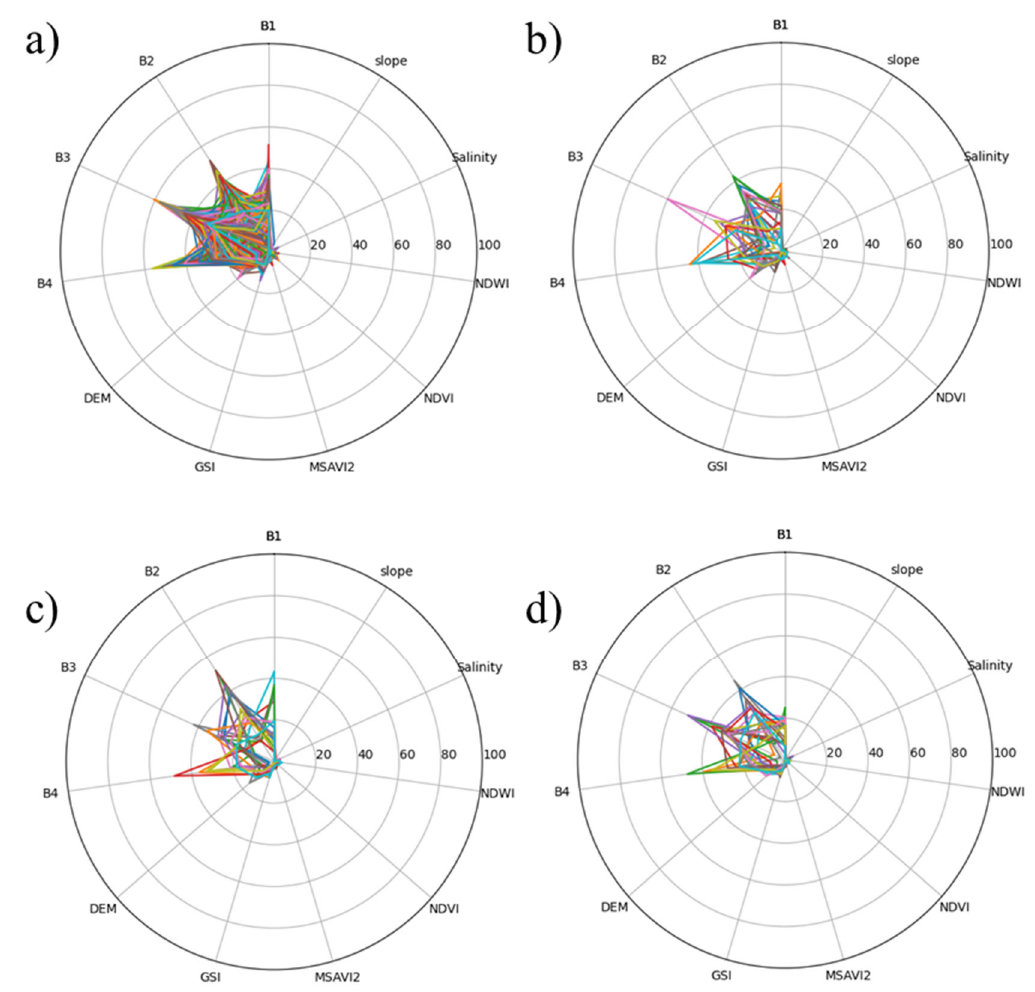
Figure 14. The relative importance of covariates ranked by GBDT to extract liquefaction. ( a ) The statistics of the importance of covariates in all 380 repeated experiments with different sets of training samples. ( b ) The statistics of the importance of covariates in 20 repeated experiments when the number of training samples is 90. ( c ) The statistics of the importance of covariates in 20 repeated experiments when the number of training samples is 270. ( d ) The statistics of the importance of covariates in 20 repeated experiments when the number of training samples is 630.